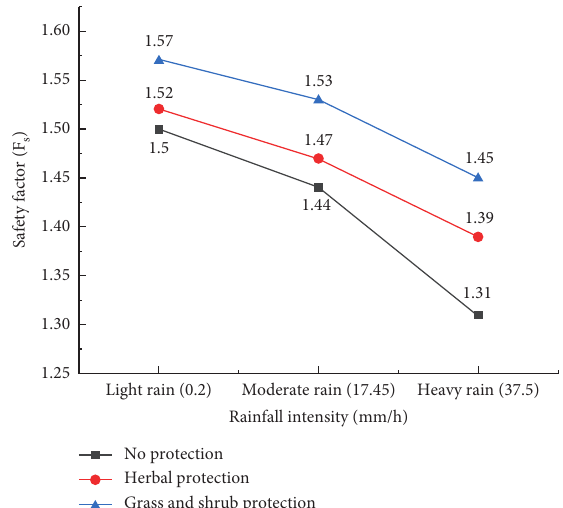
Figure 15: Curve of the relationship between rainfall time and safety